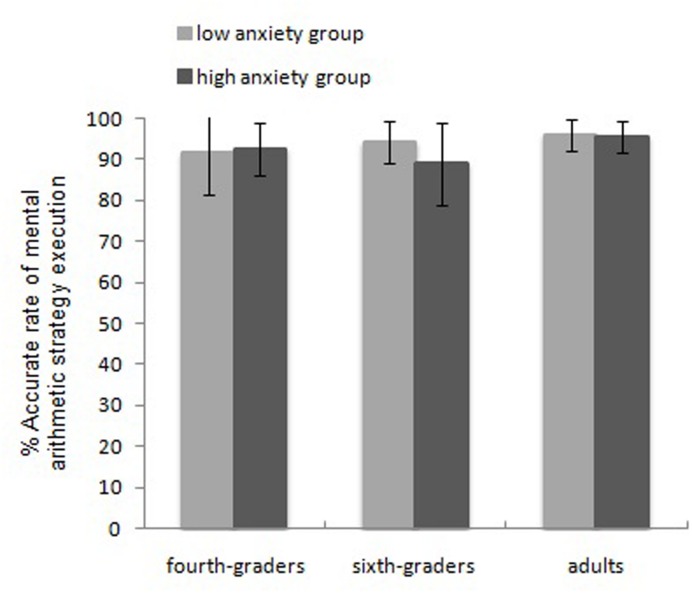
Interaction of grader groups and math anxiety in mental arithmetic strategy execution.